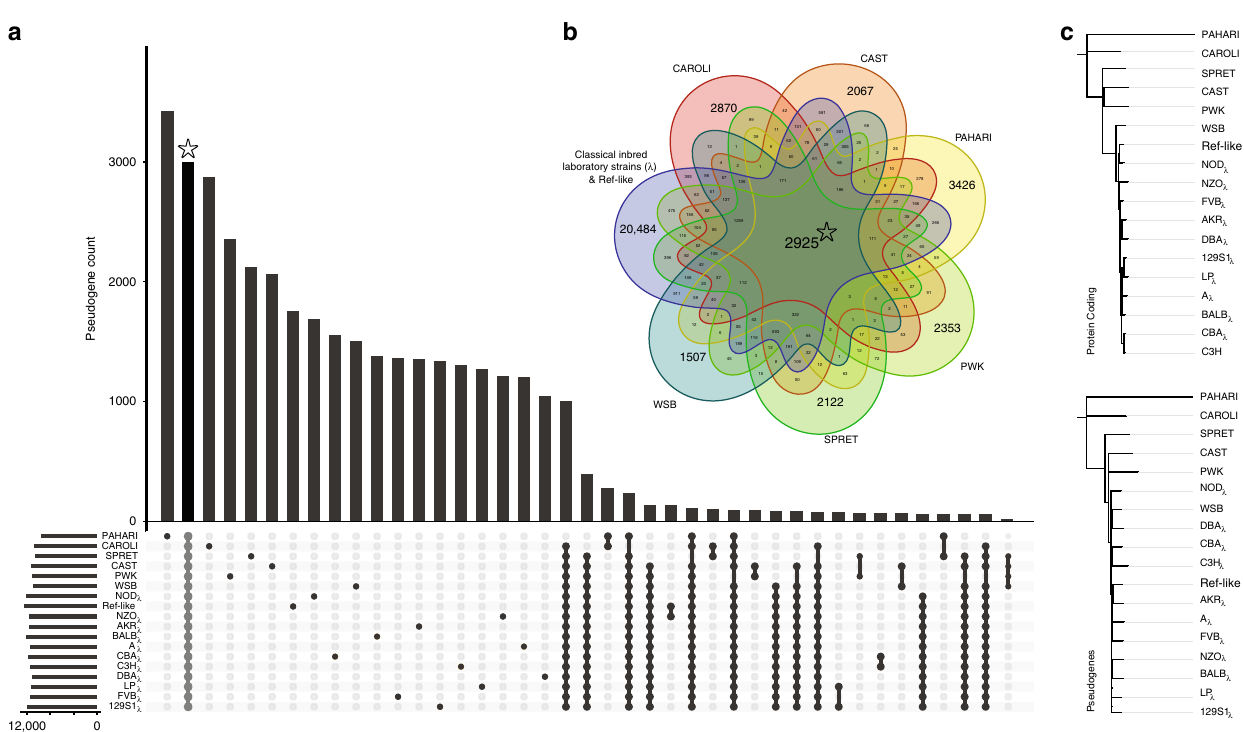
Fig. 3 Pangenome distribution of pseudogenes. a Summary of pseudogene distribution in the pangenome mouse strain dataset. The classical laboratory inbred strains are listed in Supplementary Table 4, and the laboratory inbred ‘ reference-like ’ strain refers to C57BL/6NJ. The number of pseudogenes in each strain or group of strains is shown in corresponding Venn diagram intersections shown in ( b ). b 7-way Venn diagram of evolutionarily conserved and group-speci fi c pseudogenes. c Phylogenetic trees for parents of evolutionarily conserved pseudogenes and evolutionary conserved pseudogenes. Bootstrap values are provided in mirror fi gure (Supplementary Fig.